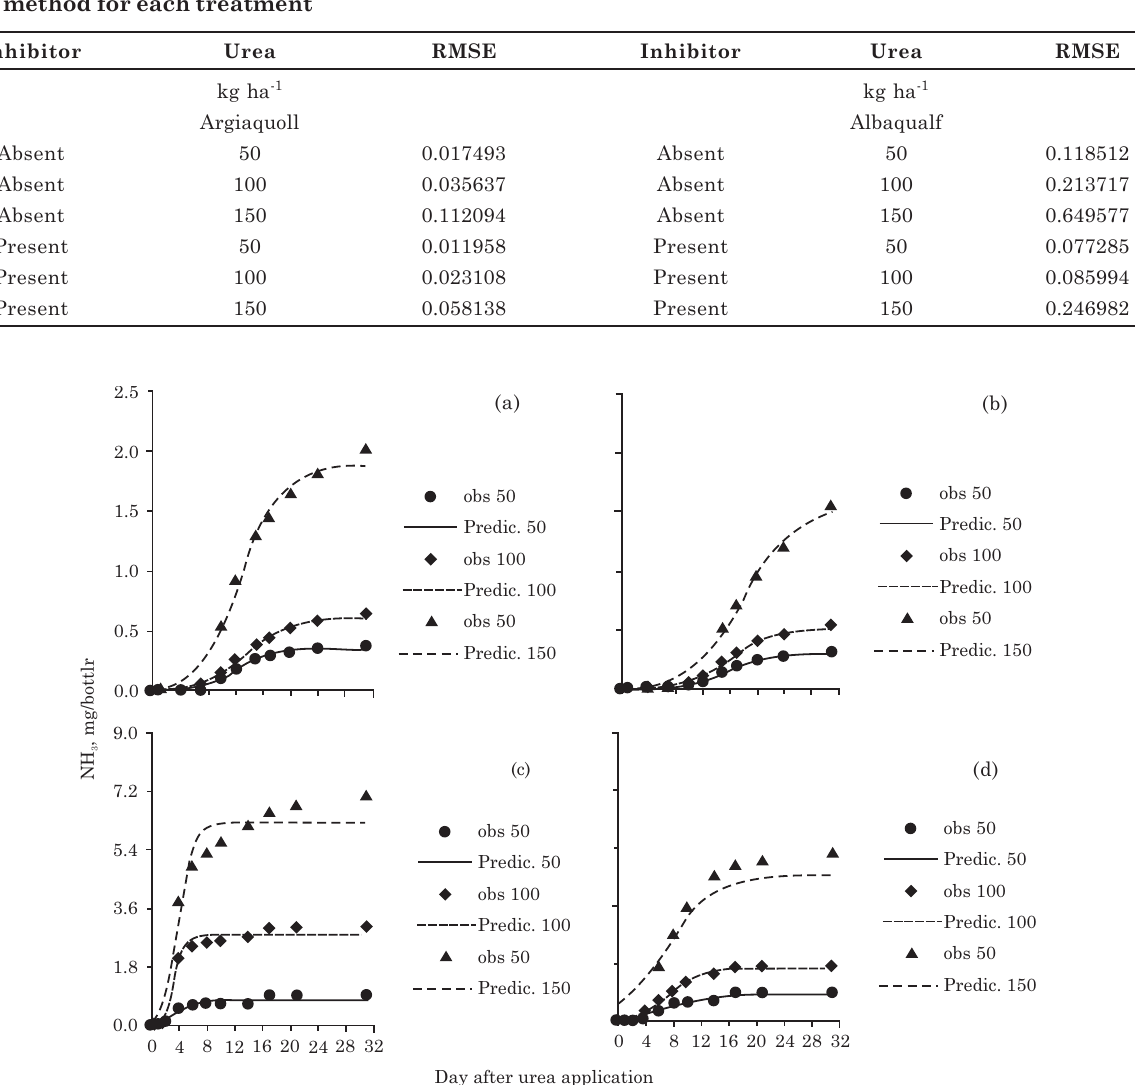
Figure 1. Observed (obs) and predicted (Predic.) cumulative ammonia volatilization losses in mg/bottle for 50, 100 and 150 kg ha -1 N applied as urea, in the absence (a,c) and presence (b,d) of urease inhibitor (NBTPT) for Argiaquoll (a,b) and Albaqualf